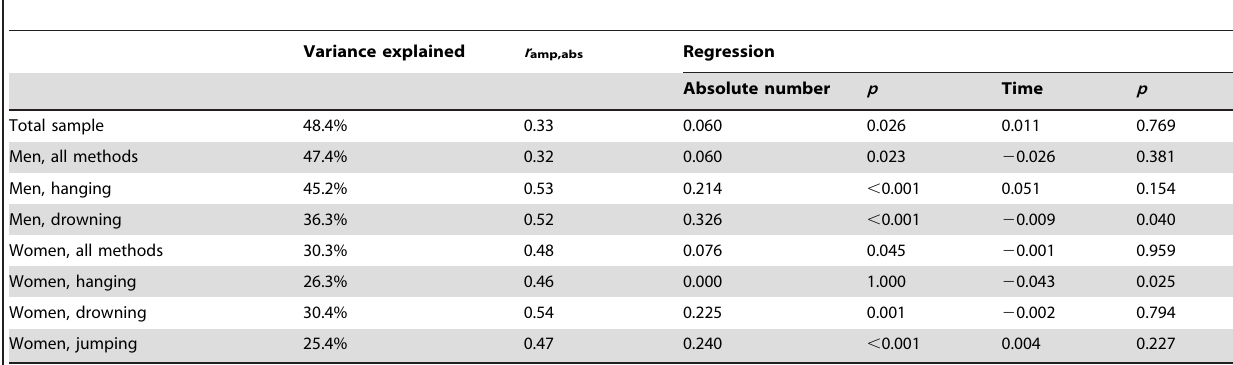
Table 4. Relation of amplitude to absolute suicide numbers and time trends in amplitude of suicide